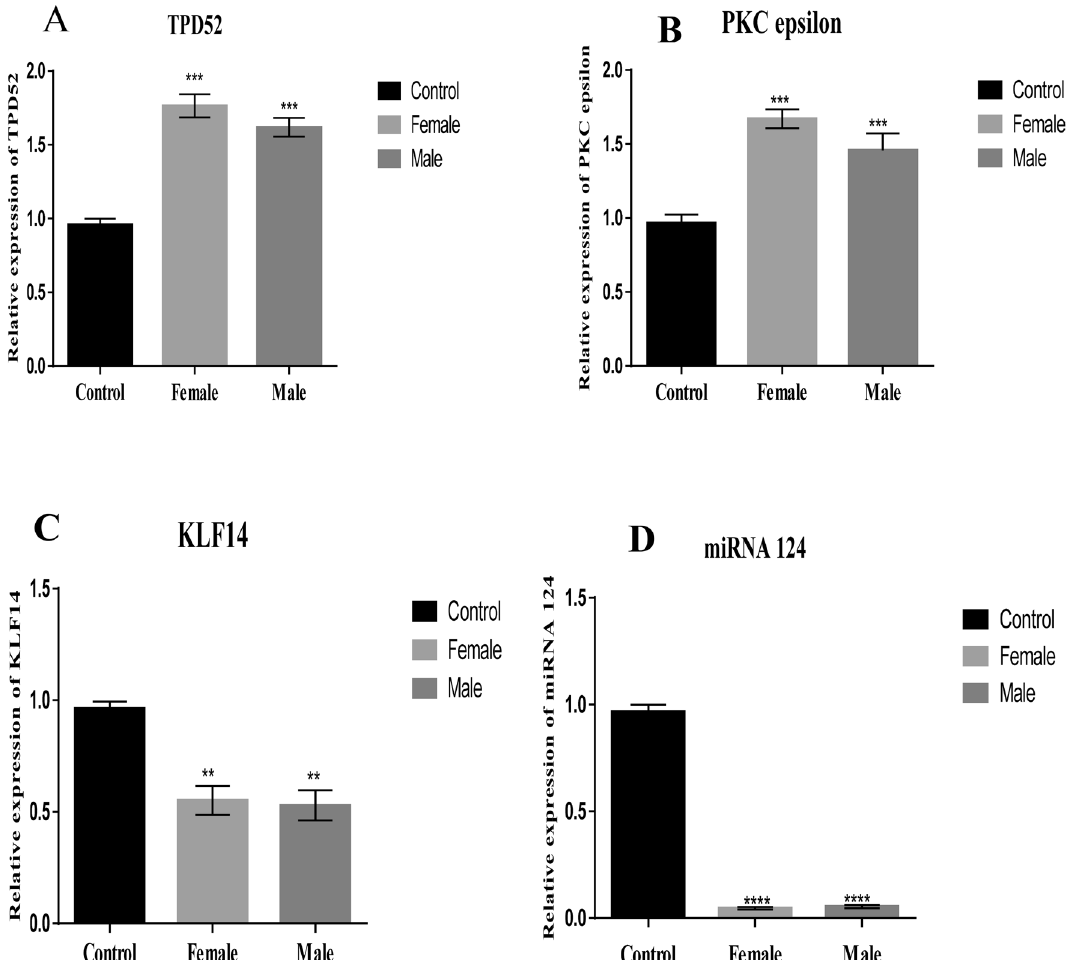
Figure 4. Expression of TPD52, PKCε, KLF14 and miRNA124 in male and female patients. ( A ) Expression of TPD52 in male and female patients compared to healthy male and female controls, respectively; ( B ) Expression of PKCε in male and female patients compared to healthy male and female controls, respectively; ( C ) Expression of KLF14 in male and female patients compared to healthy male and female controls, respectively; ( D ) Expression of miRNA 124 in male and female patients compared to healthy male and female control, respectivelys. There is significant difference of PKCε, TPD52, miRNA124, and KLF14 between male and female patients group and healthy control ( P = 0.0003, P = 0.0002, P < 0.0001, P = 0.0027 respectively). Representative data were presented as mean ± SEM of triplicate experiments. Statistical significance was measured by one-way ANOVA (**** P < 0.0001, *** P < 0.01, ** P <